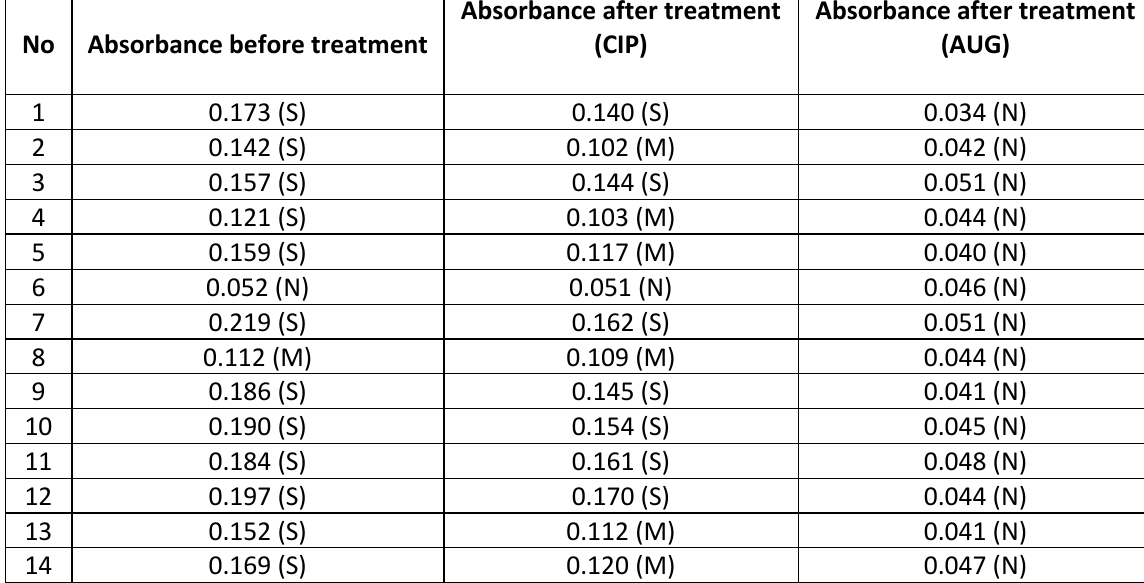
Table 3. Biofilm formation before and after treatment.